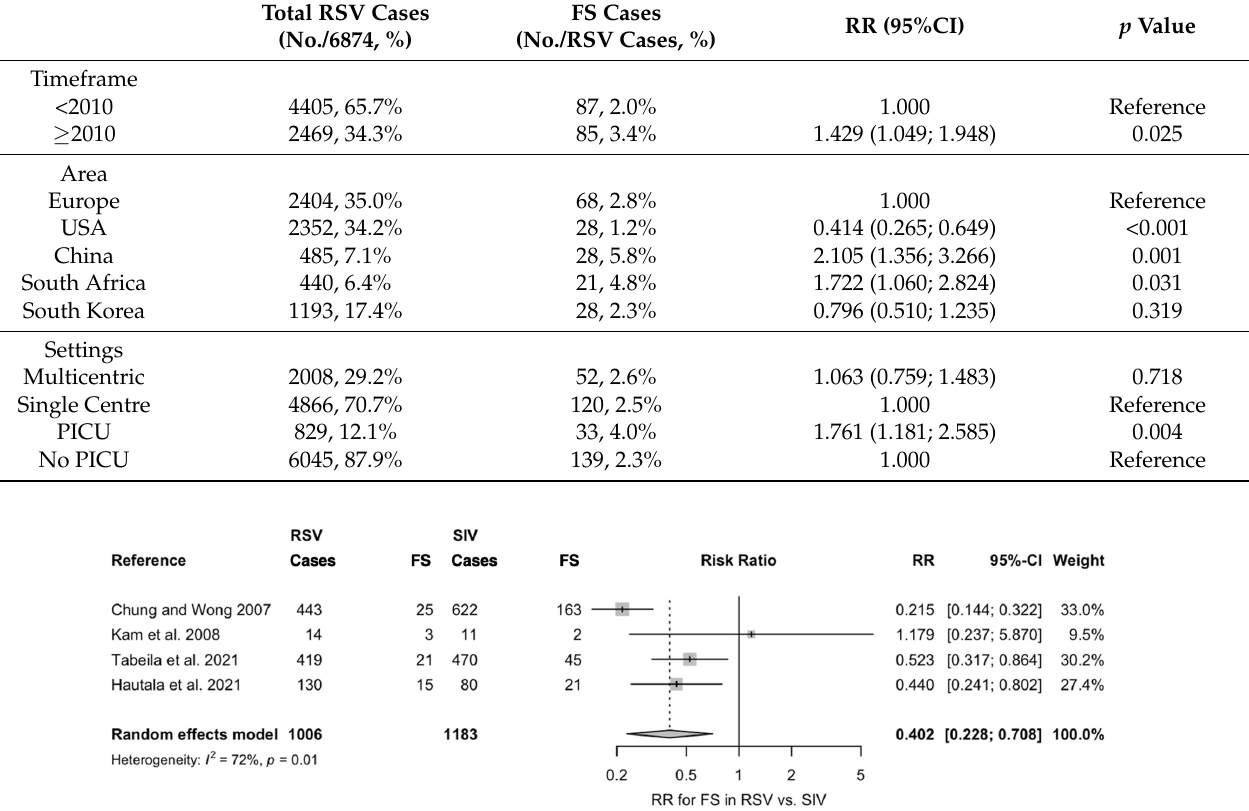
Figure 3. Risk Ratio (RR) for febrile seizures (FS) in cases of Respiratory Syncytial Virus (RSV) infections compared to Seasonal Influenza Virus (SIV) in the four studies that included both laboratory diagnoses (Note: 95%CI = 95% confidence intervals) [31,33,35,37]. Funnel plots and regression tests for funnel plot asymmetry were calculated in order to ascertain the presence of publication bias. In a funnel plot, studies’ effect sizes are plot- ted against their standard errors. Each point represents a separate study, and their asym- metrical distribution at visual inspection is suggestive of publication bias (i.e., publication depending not just on the quality of the research, but also on the hypothesis tested, and the significance and direction of detected effects), while their scattered distribution sug- gests that publication bias can be otherwise ruled out, as in Figure 4a. Such subjective Egger test ruled out publication bias (i.e., t = − 0.01, df = 9, p -value = 0.990). Similarly in radial plots (Figure 4b), estimates were substantially scattered across the regression line, suggesting no significant small study effect.